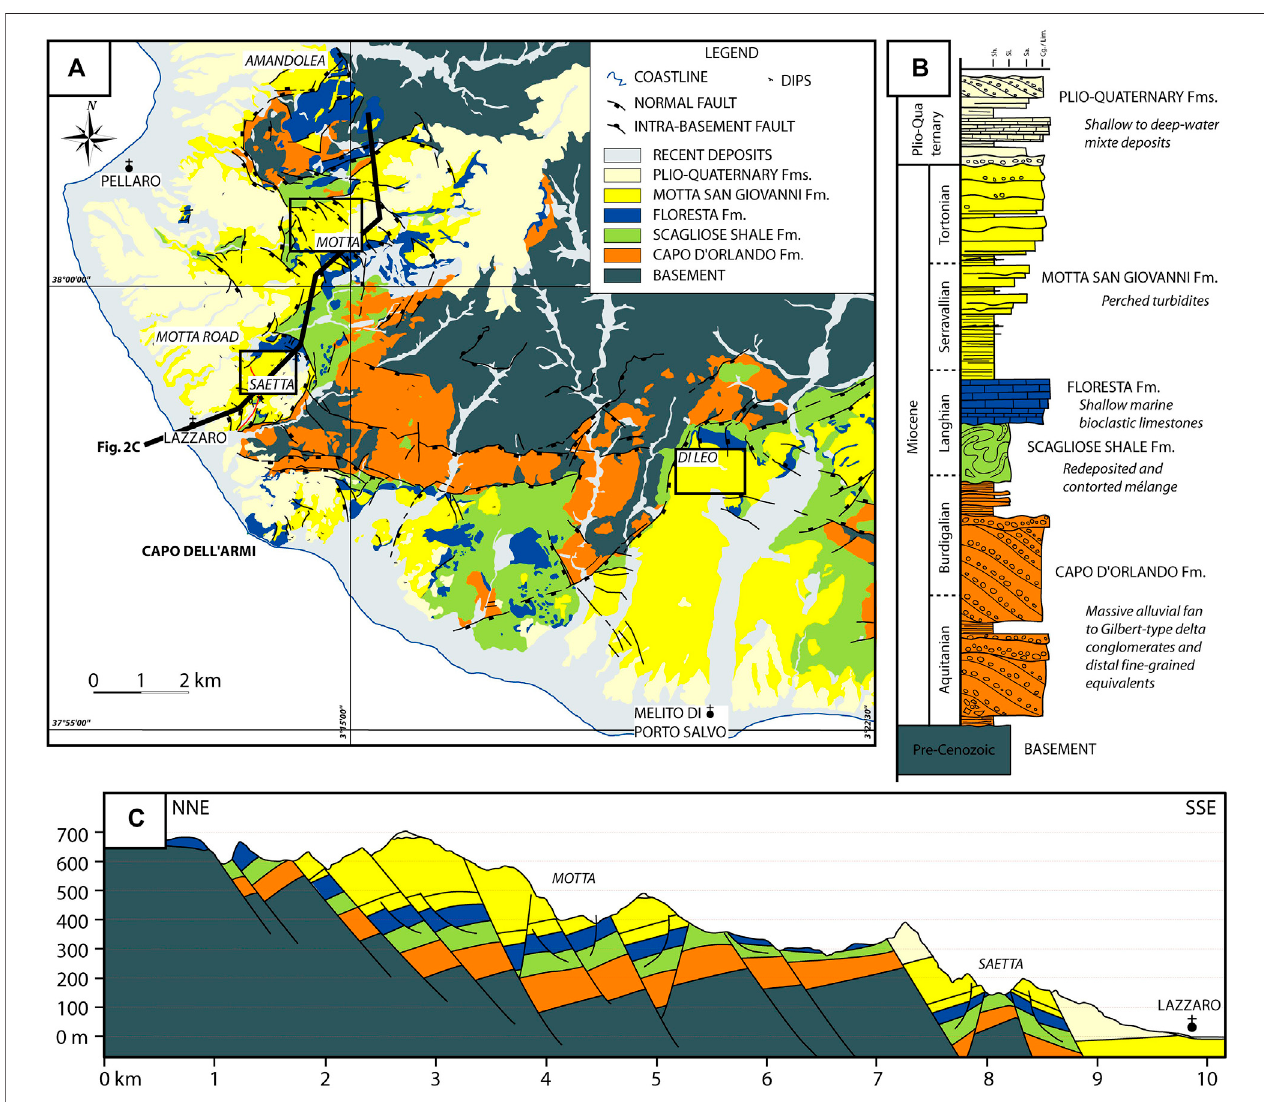
FIGURE 2 | (A) Simpli fi ed geological map of the southwestern most part of Calabria. The three areas studied in very high resolution for stratigraphic issues are illustrated with black rectangle. (B) Schematic stratigraphic section of the Cenozoic deposits in the southwestern most part of Calabria. Sh., Shale; Si., Siltstone; Sa., Sandstone; Cg./Lim., Conglomerate or Limestone. (C) Cross-section illustrating the tilted block and structural pattern in the Motta and Saetta areas. See location on Figure 2A .